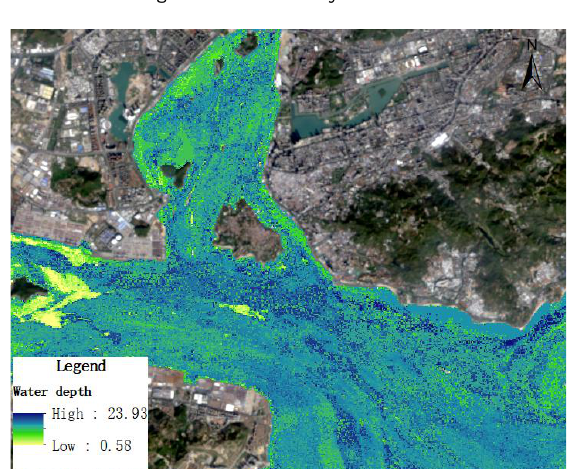
Figure7. The result of water depth